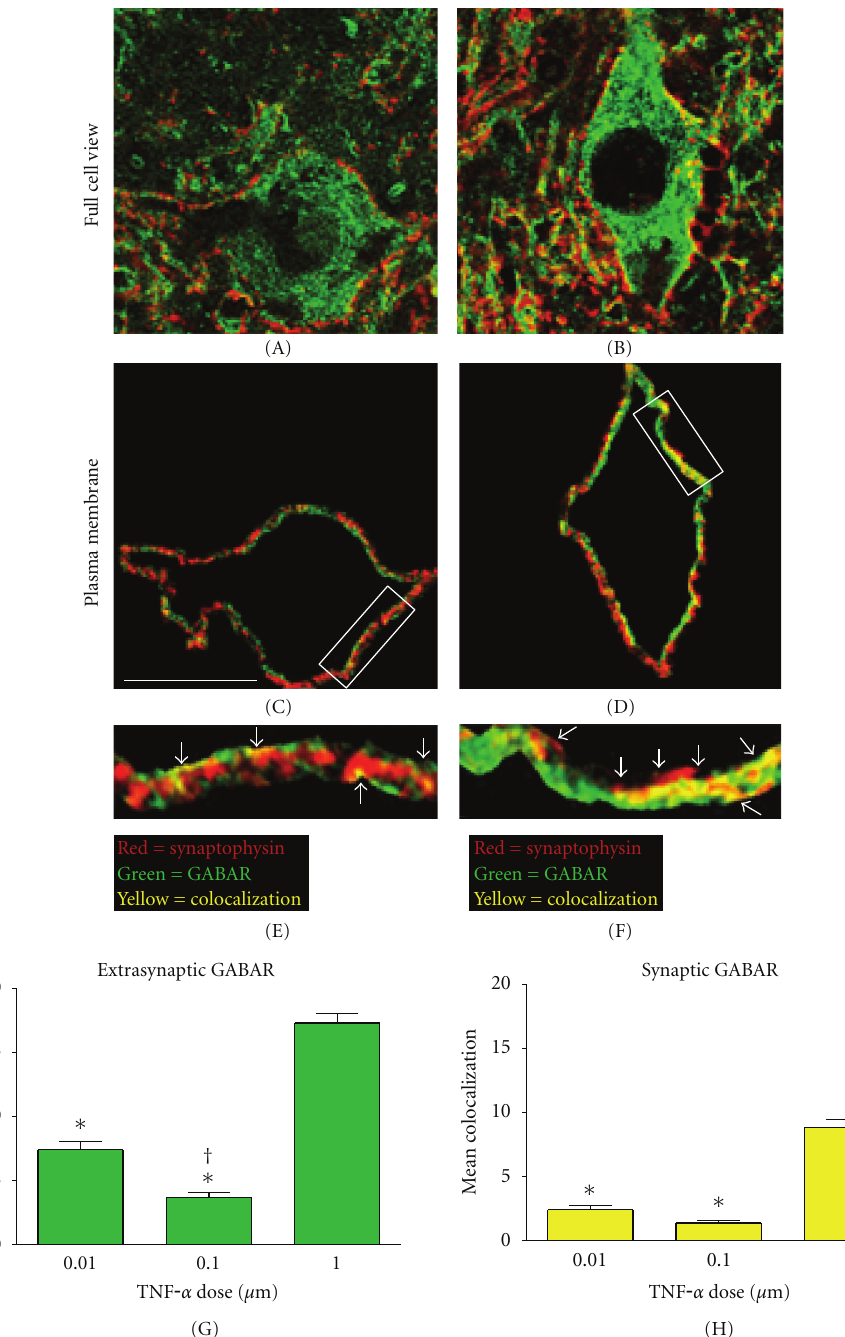
Figure 5: Increased GABA A Rs on the plasma membrane of spinal neurons after TNF α injection. ((a) and (b)) An image analysis program identified the confocal plane with the greatest colocalization of GABA A R and synaptophysin for each motor neuron. ((c) and (d)) A 2 μ m wide cutout of the image containing the somatic plasma membrane. ((e) and (f)) Boxed plasma membrane fractions enlarged to demonstrate representative di ff erences in extrasynaptic (green) and synaptic (yellow) GABA A R puncta on the plasma membrane following the highest and lowest injections of TNF α in vivo . ((g) and (h)) The highest dose of TNF α yielded a significant increase in extrasynaptic and synaptic GABA A Rs on the plasma membrane (extrasynaptic GABA A R ∗ P < 0 . 001 from low and middle dose; synaptic GABA A R ∗ P < 0 . 001 from low and middle dose). Furthermore, the lowest dose of TNF α produced a significant increase in extrasynaptic GABA A Rs relative to the middle dose ( † P = 0 . 002). Bars represent group means across > 800 confocal image stacks (12 subjects, n = 4 subjects per group). Error bars reflect SEM. Scale bar, 30 μ